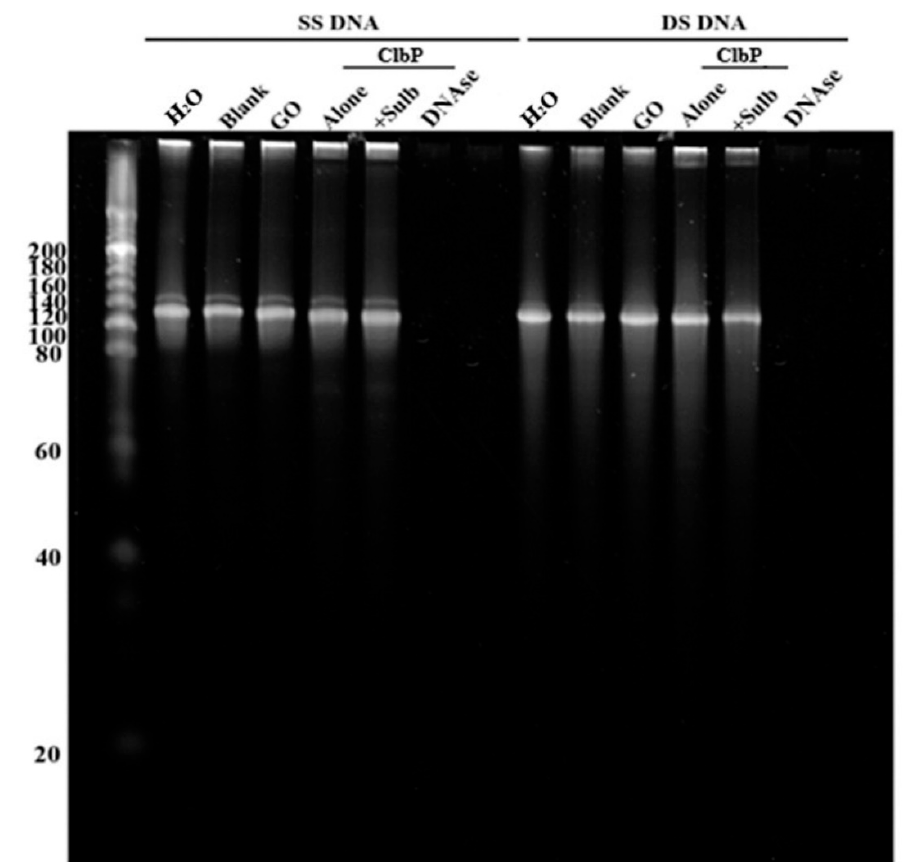
Figure 7. Test of the DNAse activity of the purified ClbP enzyme. GO (glycine oxidase) is used here as negative control enzyme.